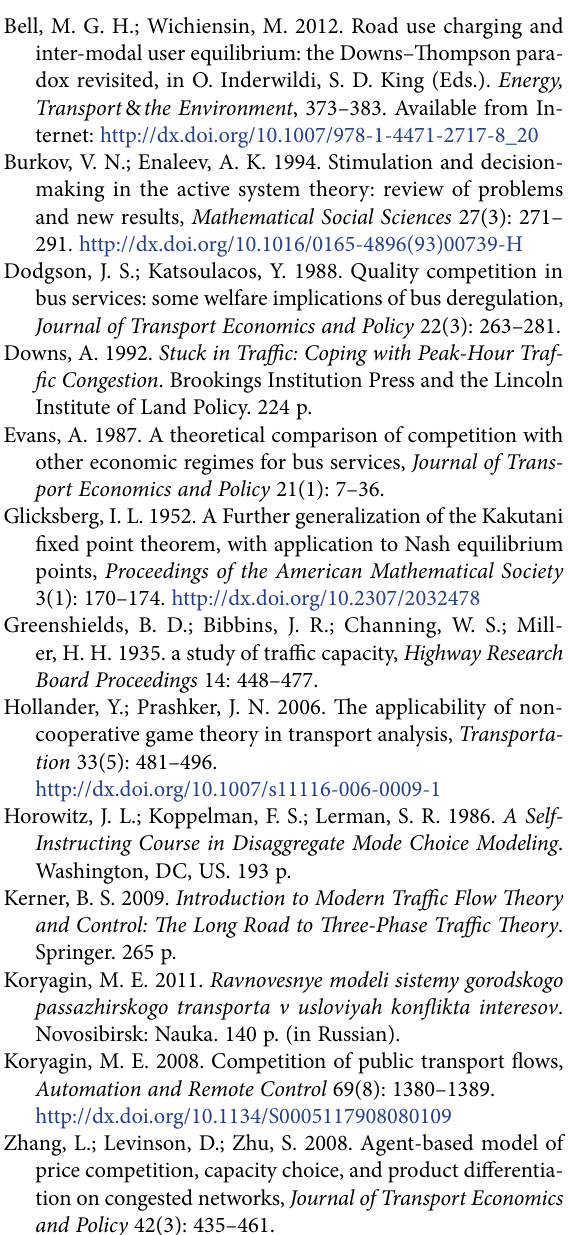
Table. Travel time and road capacity changes, when parameter increase Statement Parameter both both both both Value of time increase increase increase increase Intensity of opposite opposite opposite opposite passenger flow Fare at public both both both both transport convex increase increase